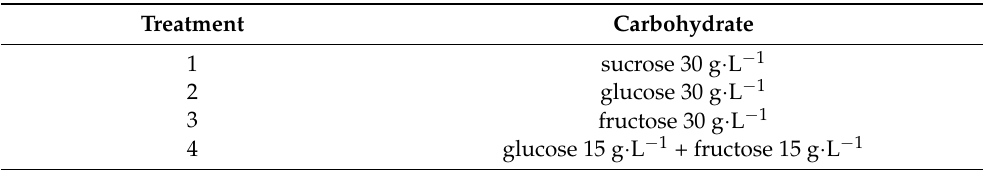
Table 8. Modifications regarding the type and content of carbohydrates in MS medium used in the Experiment